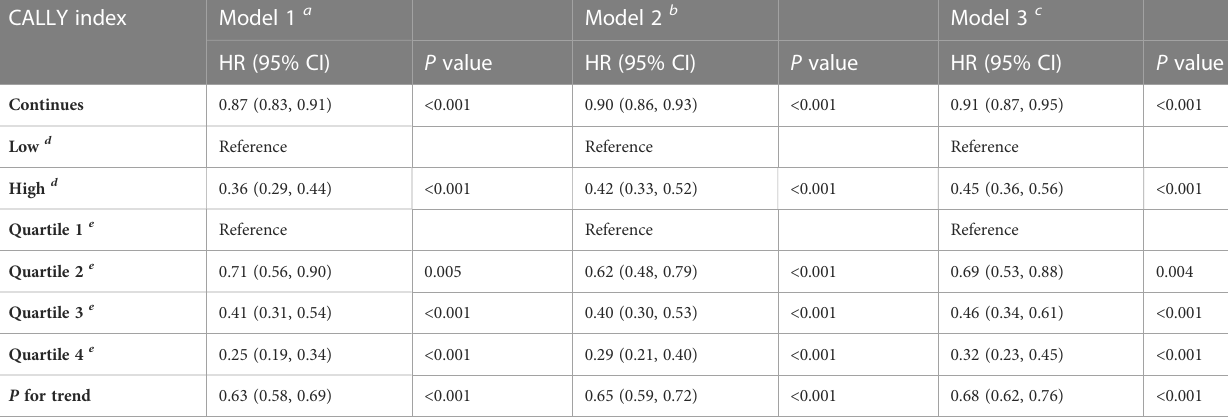
TABLE 2 Associations between the CALLY index and OS in patients with CRC.